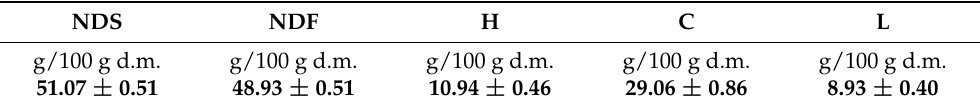
Table 1. The content of neutral detergent soluble (NDS), neutral detergent fiber (NDF), hemicellulose (H), cellulose (C) and lignin (L) in hop stems. NDS NDF H C L g/100 g d.m. g/100 g d.m. g/100 g d.m. g/100 g d.m. g/100 g d.m.